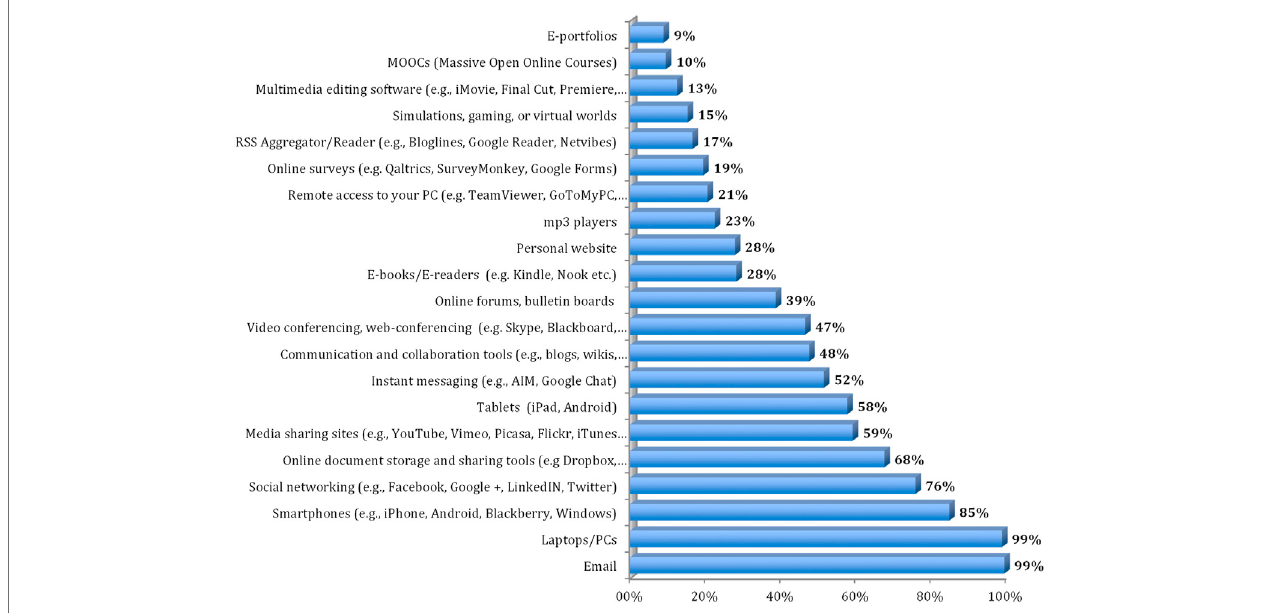
FIGURE 3 | Percentage of instructors using each technological tool on a daily or weekly